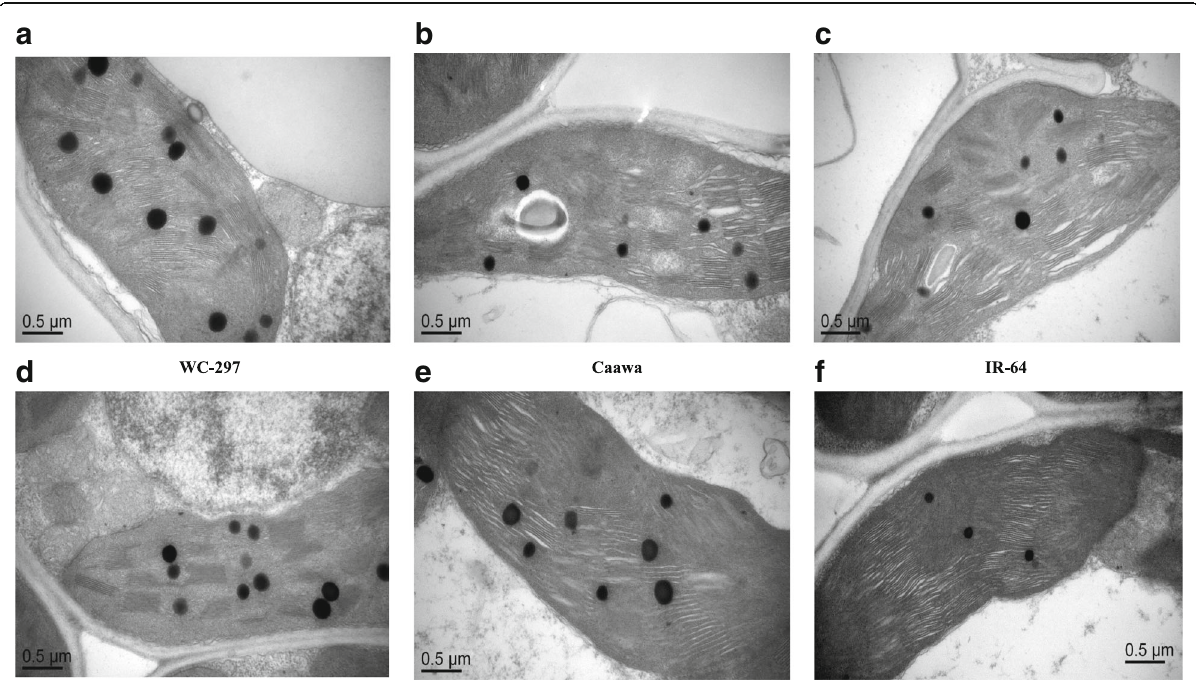
Fig. 8 Chloroplast of rice genotypes in the presence of osmotic stress. a-c Chloroplasts of the non-inoculated plants of WC-297, Caawa and IR-64, respectively. d-f Chloroplasts of the inoculated plants of WC-297, Caawa and IR-64, respectively. Grana in chloroplasts are better organized in rice plants inoculated with P.